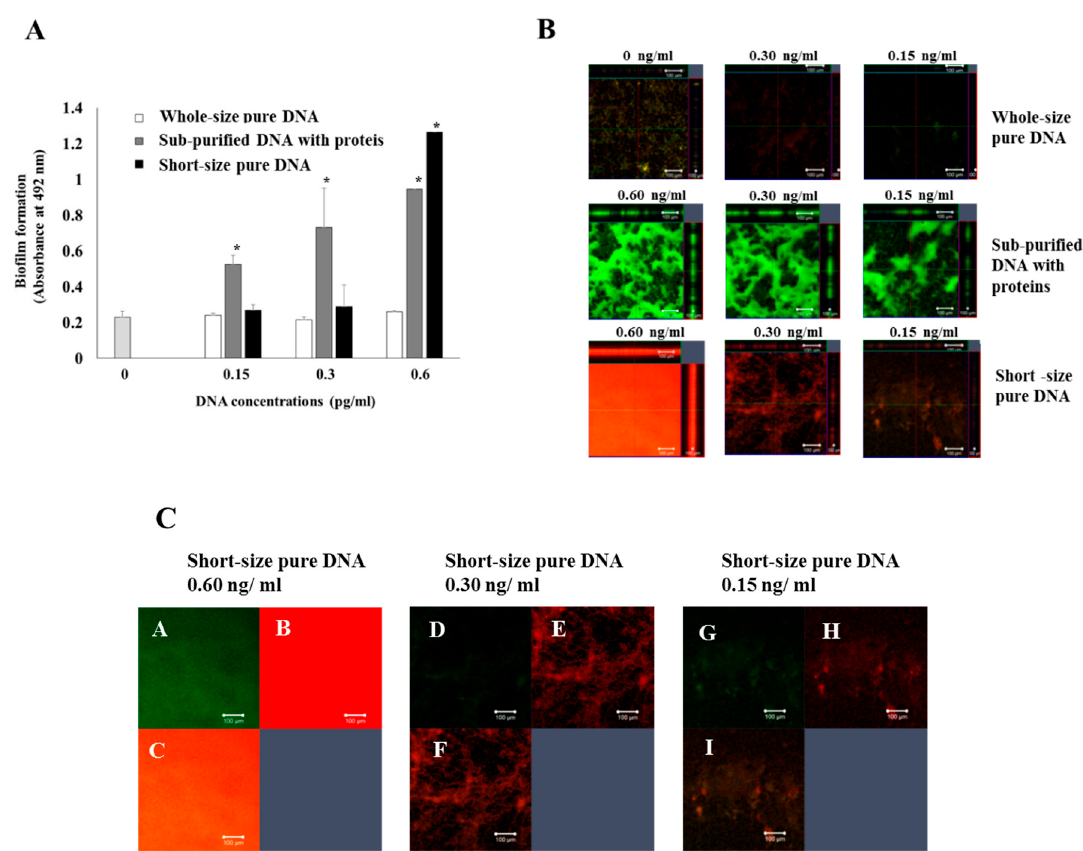
Figure 5. Biofilm formation of S. mutans by DNA. Biofilm formations induced by 0, 0.15, 0.3, and 0.6 ng/mL of whole-size pure DNA (open bar), sub-purified DNA with proteins (gray bar) from 180-s cell destruction and short-size pure DNA in UA159 were quantitatively assessed by absorbance at 492 nm ( A ). The data indicate the mean ± standard deviation (SD) of triplicate experiments. The independent experiments were performed three times, with similar results obtained each time. The asterisks indicate a significant difference between the two groups (*: p < 0.05, no DNA vs. DNA). Biofilm formations induced by 0, 0.15, 0.3, and 0.6 ng/mL of whole-size pure DNA, sub-purified DNA with proteins and short-size pure DNA were visually observed by confocal microscope with live/dead staining ( B ). X – Y , X – Z , and Y – Z axes biofilms are shown in each picture. Representative data from more than three independent experiments are shown in the pictures. The biofilm formations of S. mutans UA159 .gtfBC − , which were induced by various concentrations of short-size pure DNA, were stained by the Live/Dead BacLight Viability Kit, observed by confocal microscope and analyzed (Zen). Live ( A , D , G ), dead ( B , E , H ), and merged cells ( C , F , I ) in quadrant square images are shown ( C ). Representative data from more than three independent experiments are shown in the pictures.